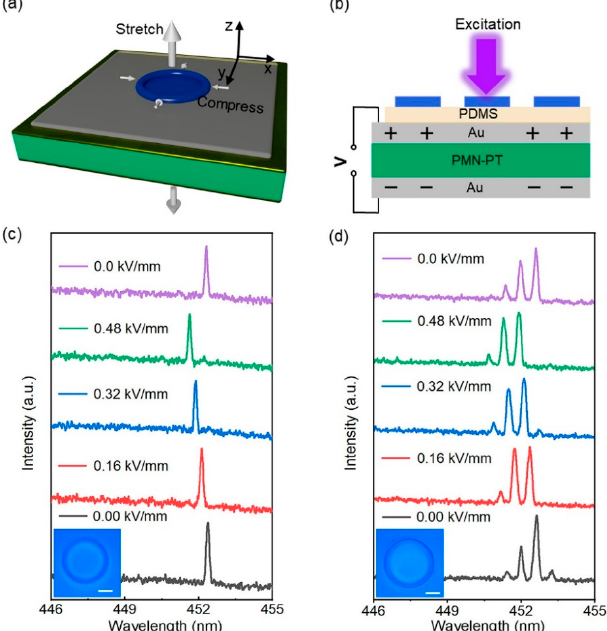
Figure 3. Wavelength tuning of the microring laser. ( a ) Schematic diagram of laser device deformation. ( b ) In situ measurement of laser spectra under an electric field. ( c ) Laser spectra of 58 µ m diameter microring under different electric fields. Inset: Microscope image of the microring. The scale bar is 20 µ m. ( d ) Laser spectra of 70 µ m diameter microring under different electric fields. Inset: microscope image of the microring. The scale bar is 20 µ